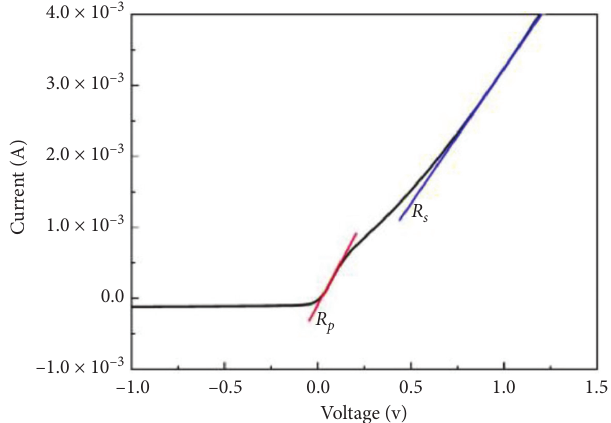
Figure 4: I–V curves of pin photodiode at